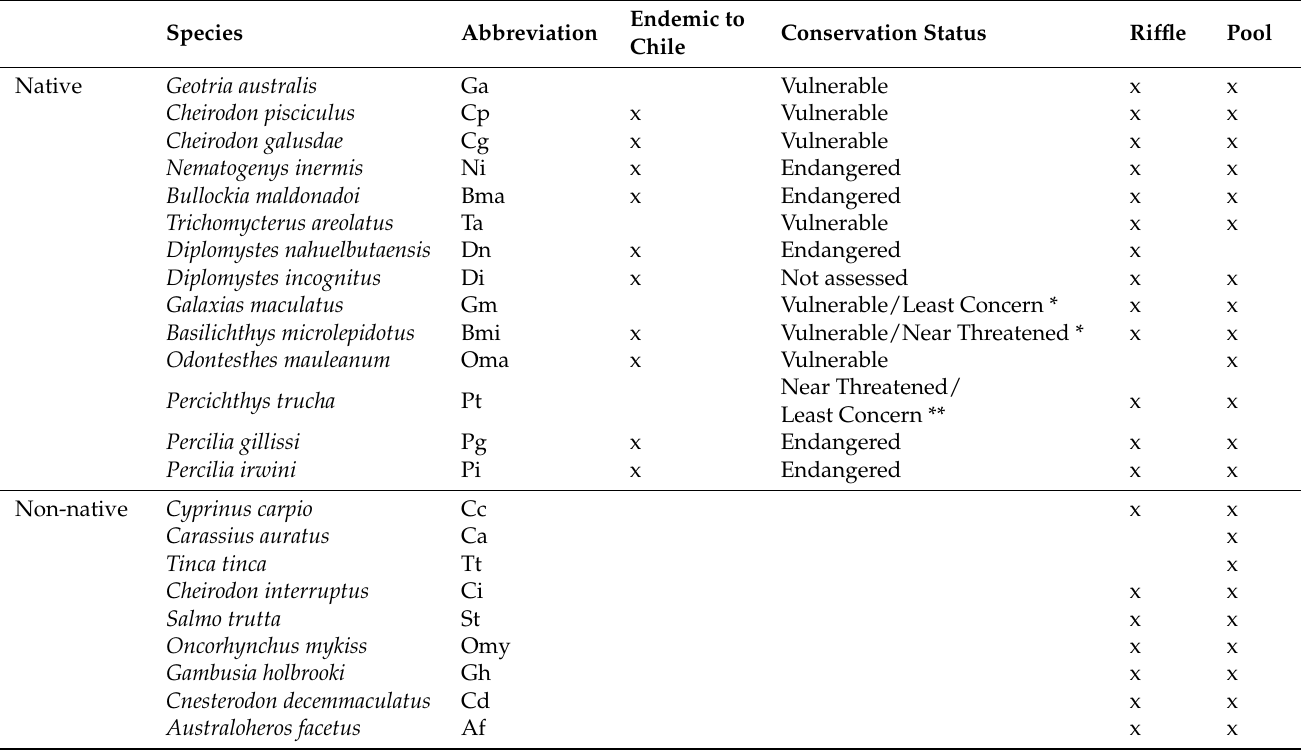
Table 1. List of native and non-native fish species present in the study area, in addition to their habitat type, conservation category, and endemism. An “x” indicates presence in different habitat types. Endemic to Species Abbreviation Conservation Status Riffle Chile